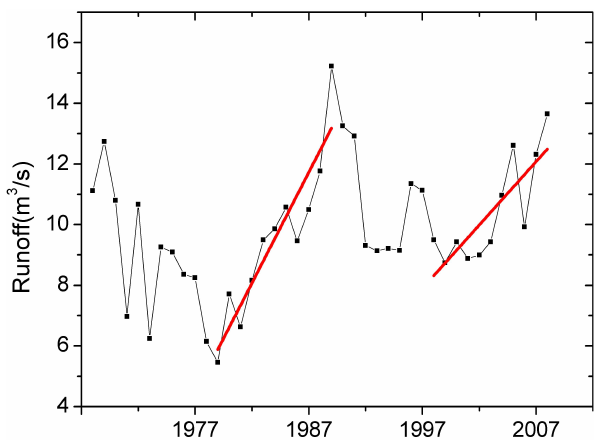
Fig. 10. Monthly spring snowmelt runoff changes of QiLian station (March to May).